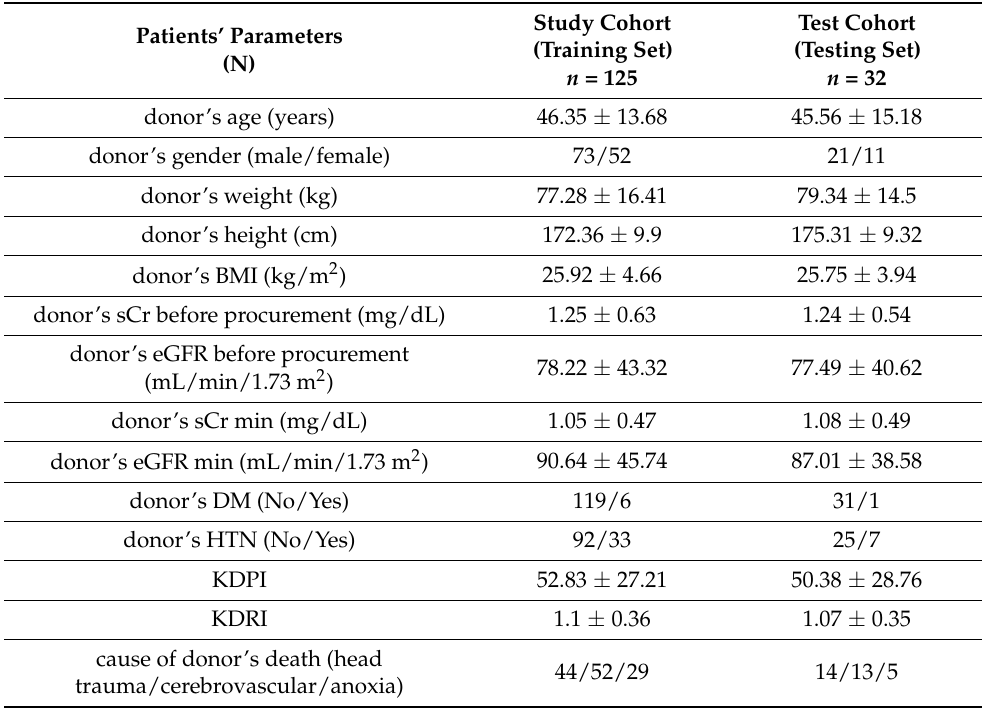
Table 2. Baseline characteristics of the donors and recipients enrolled in the cohorts. Most donors (69 out of 88) provided a total of 138 records for each transplant procedure and 19 donors provided individual records. Training and testing sets are described by mean ± standard derivation (SD) and range from minimal to maximal value or as categorical, if